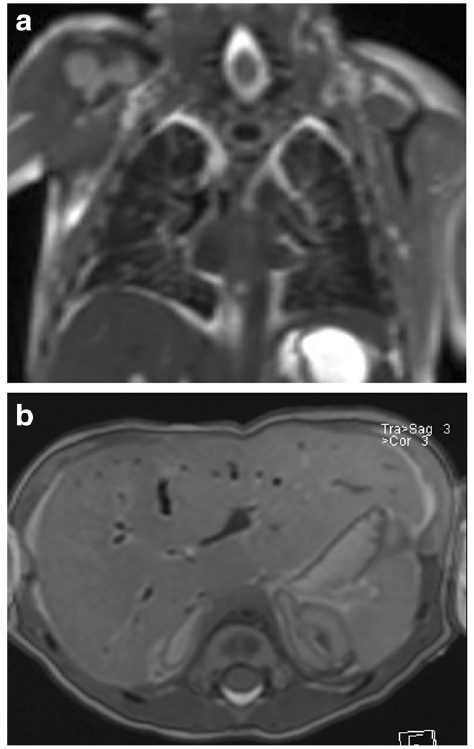
Fig. 4 Postmortem fetal magnetic resonance imaging (PMFMRI) in a term stillbirth. Physiological postmortem changes. a Coronal T2-W image showing dark appearance of the lungs containing air. b Axial T2-